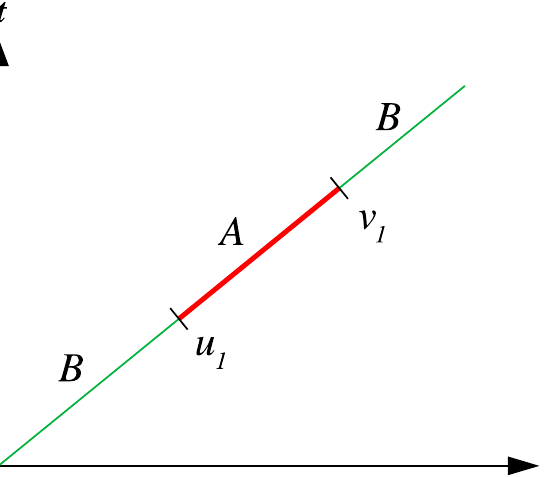
Fig. 3 A single boosted interval in a GCFT 1 + 1